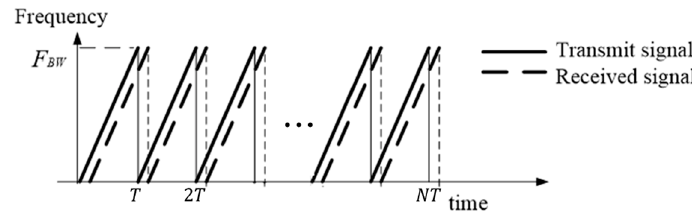
Figure 1. Multi-chirp FMCW waveform.